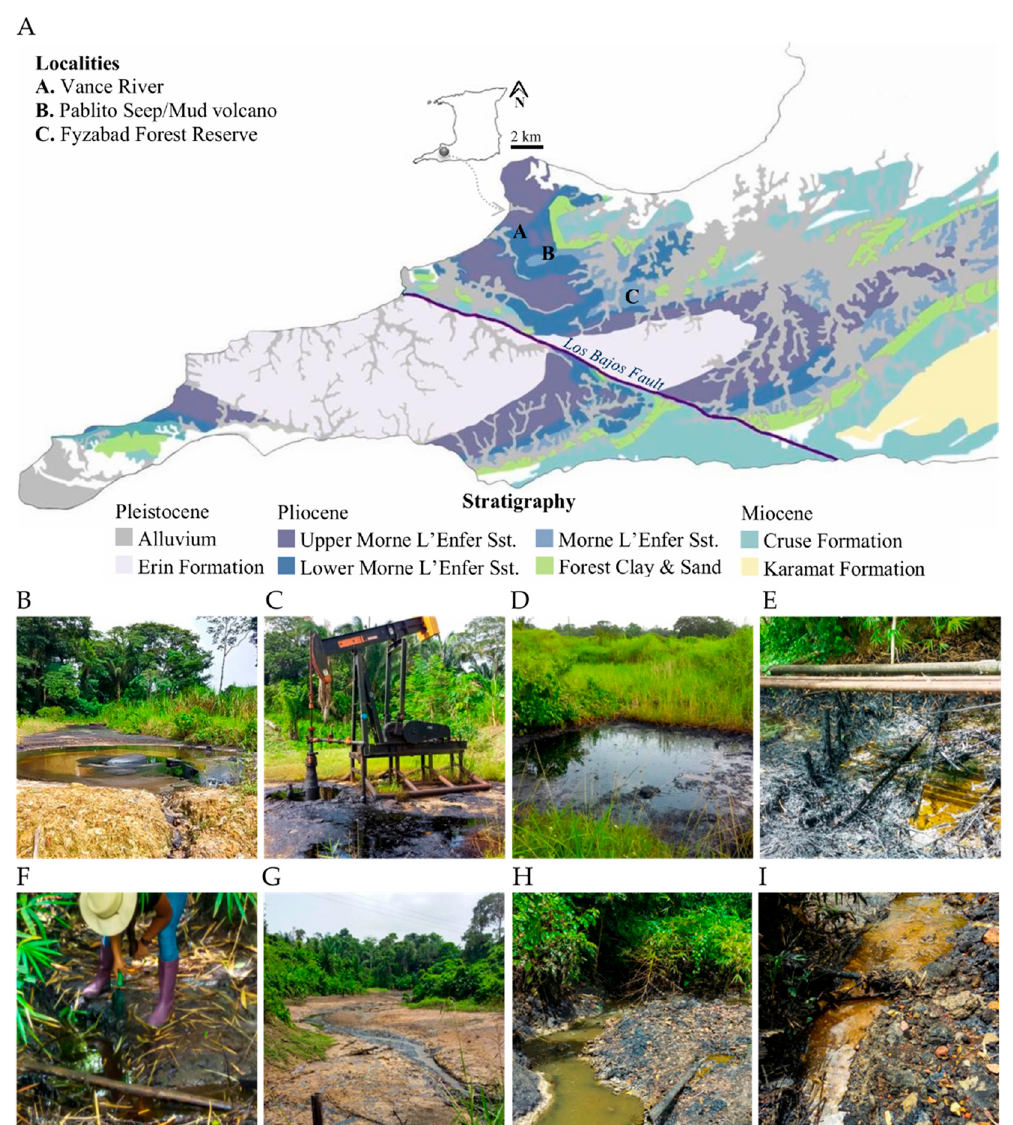
Figure 1. Sampling site description. ( A ): Locations of the sampling sites in southwestern Trinidad. Sites were concentrated in Plio-Pleistocene formations, with surrounding active oil fields and seeps. Letters on the map represent the localities mentioned in the text, and the colors represent various geological formations. Geological formations are redrawn from Kugler [54], Chen et al. [55], Dasgupta et al. [56], and Baboolal et al. [57]. The 8 sampling sites in the 3 geographically separated locations in southwestern Trinidad: ( B ): Pablito P1; ( C ): Fyzabad F1; ( D ): Fyzabad F2; ( E ): Vance river V1; ( F ): Vance river V2; ( G ): Vance river V3; ( H ): Vance river V4; ( I ): Vance river V5. Photographs by AC Ramdass and SN